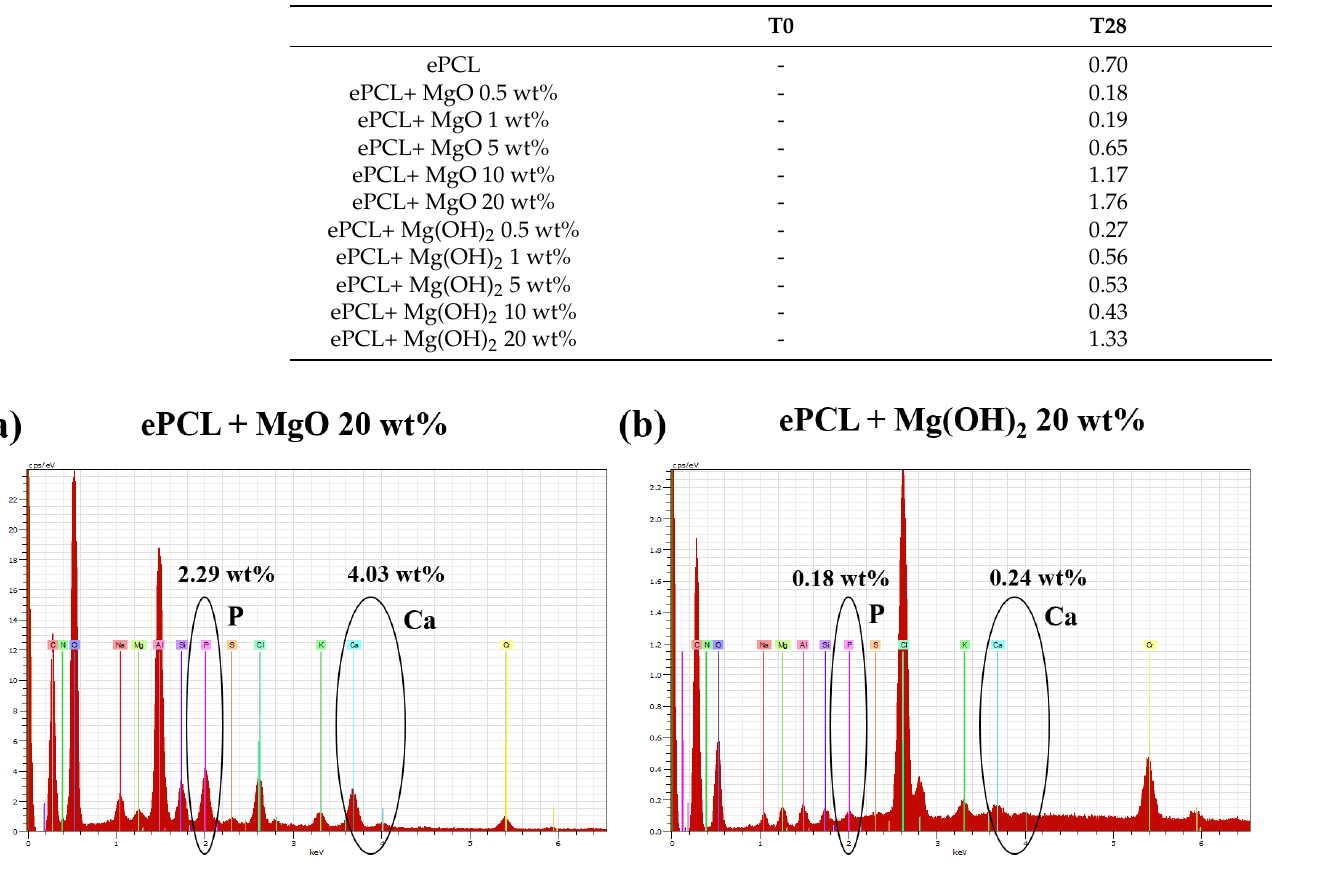
Figure 12. EDX analysis of ( a ) ePCL + MgO 20 wt% and ( b ) ePCL + Mg(OH) 2 . In the circles the signals for P and Ca are shown.